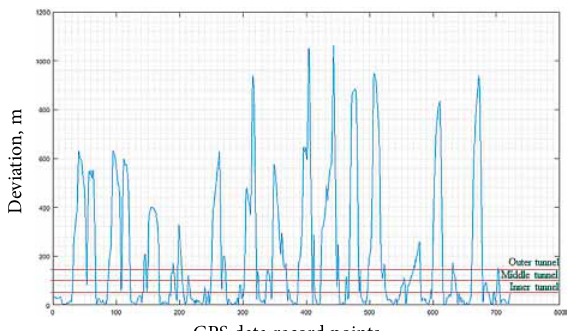
Fig. 11. Dependence of flight deviation from data